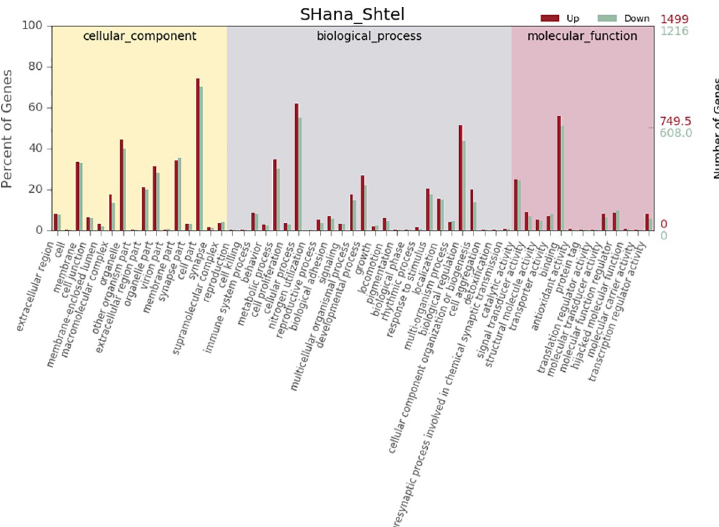
Fig 4. GO classification of DEGs. The results are summarized in three main categories: biological process, cellular component and molecular function. The X-axis indicates the second level term of gene ontology; The Y-axis shows the percentage of genes. red, up regulated genes; green, down regulated genes.